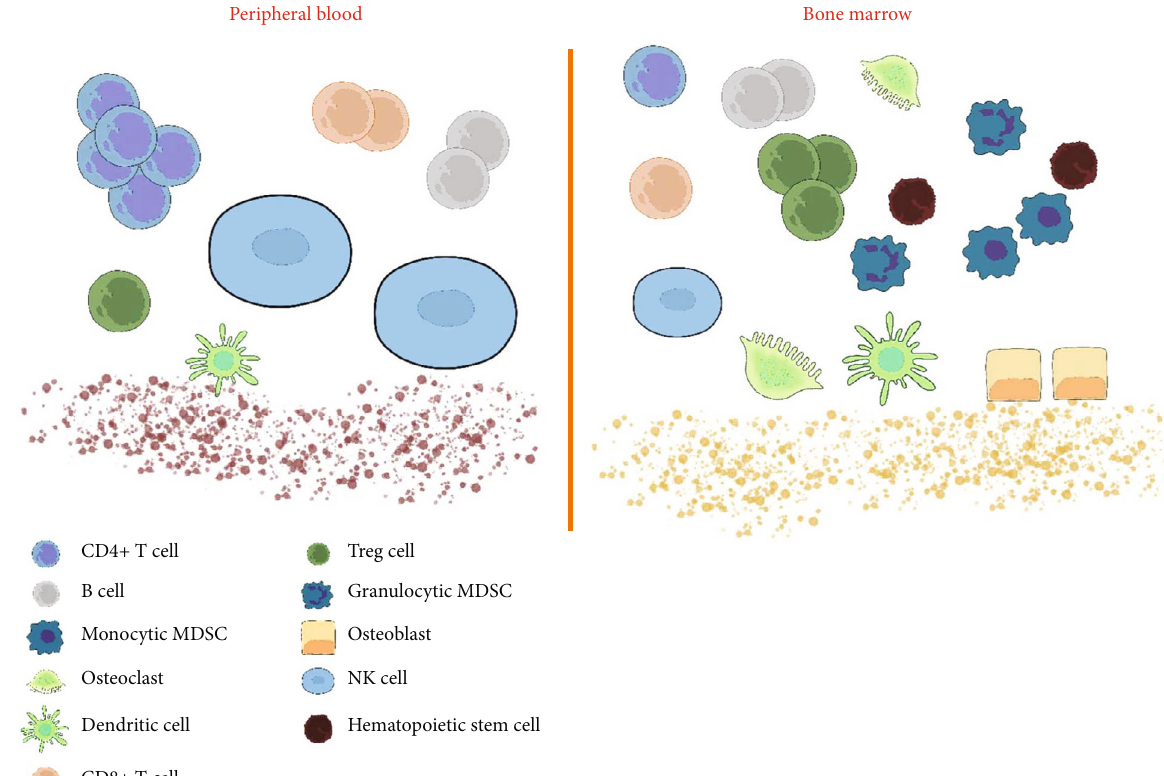
Figure 1: The di ff erence between peripheral blood and bone marrow immune microenvironment. Compared with peripheral blood, there are a large number of immature and suppressive immune cell types in the bone marrow. CD4+ T cells, CD8+ T cells, NK cells, and other immune e ff ector cells accounted for a small proportion, while immunosuppressive Treg cells and MDSCs accounted for a large proportion, which not only protected hematopoietic stem cell (HSC) but also weakened the immune killing e ff ect on tumor cells. It provides an immune- privileged niche for disseminated tumor cells. A large number of immune factors are involved in the formation and regulation of osteoblasts and osteoclasts, which also a ff ect the immune microenvironment of bone marrow.